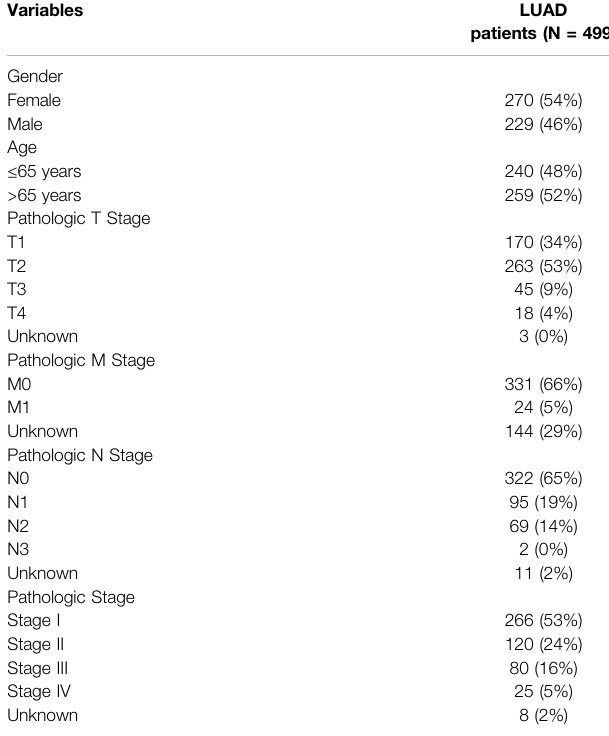
TABLE 1 | Basic clinical information of 499 LUAD patients from